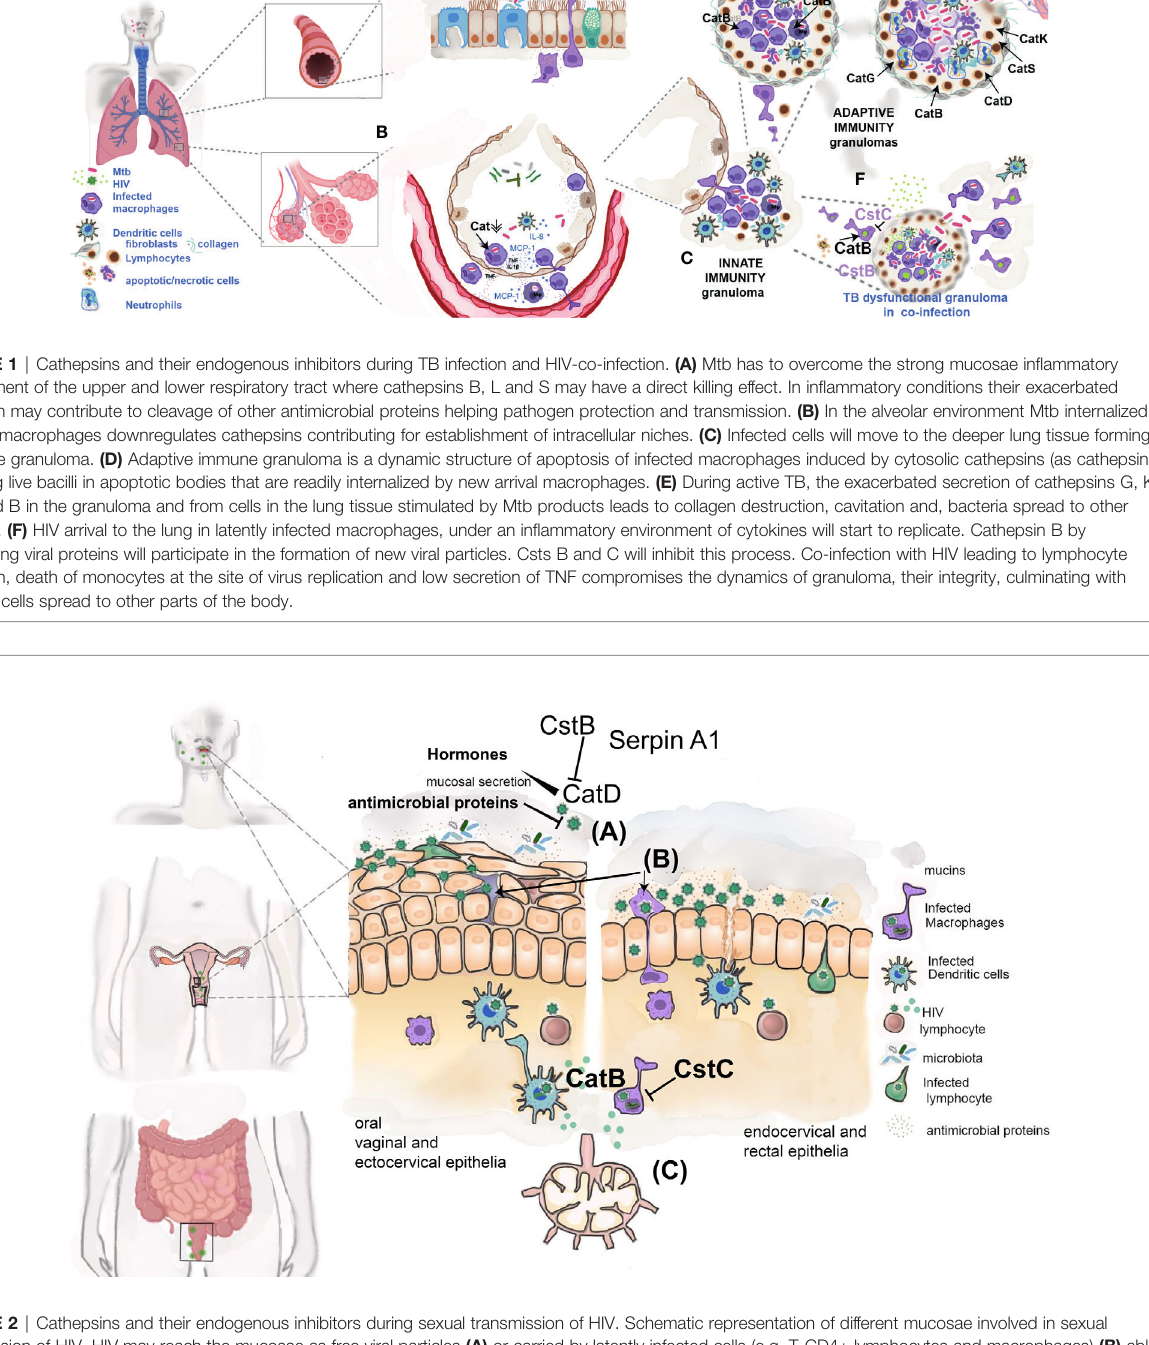
FIGURE 2 | Cathepsins and their endogenous inhibitors during sexual transmission of HIV. Schematic representation of different mucosae involved in sexual transmission of HIV. HIV may reach the mucosae as free viral particles (A) or carried by latently infected cells (e.g. T-CD4+ lymphocytes and macrophages) (B) able to transmigrate between epithelial cells. HIV must traverse the epithelial cell layer and gain access to immune cells present in subepithelial layer. The mucus layer enriched with several antimicrobial proteins secreted in response to microbiota and pathogen MAMPs further contributes to inactivate HIV. The presence of cathepsin D (CatD) secreted by vaginal epithelia can facilitate HIV transmission by enhancing its ability to infect CD4+ T-lymphocytes and epithelial CD4-negative cells, providing an additional mechanism used by HIV to reach subepithelial layer. Regulation of cathepsin D by hormones as well as semen and local microbiota in fl uence the infectivity of HIV. Cathepsin inhibitors Cst B, Serpin A1, Serpin A3, correlates with protection from HIV transmission. Infected DCs and macrophages may amplify virus replication by processing viral proteins using cathepsin B (C) . Cst C will inhibit this process. HIV is then able to infect susceptible target cells (CD4+ T-lymphocytes) either directly or after viral transfer from DC or macrophages at regional lymph